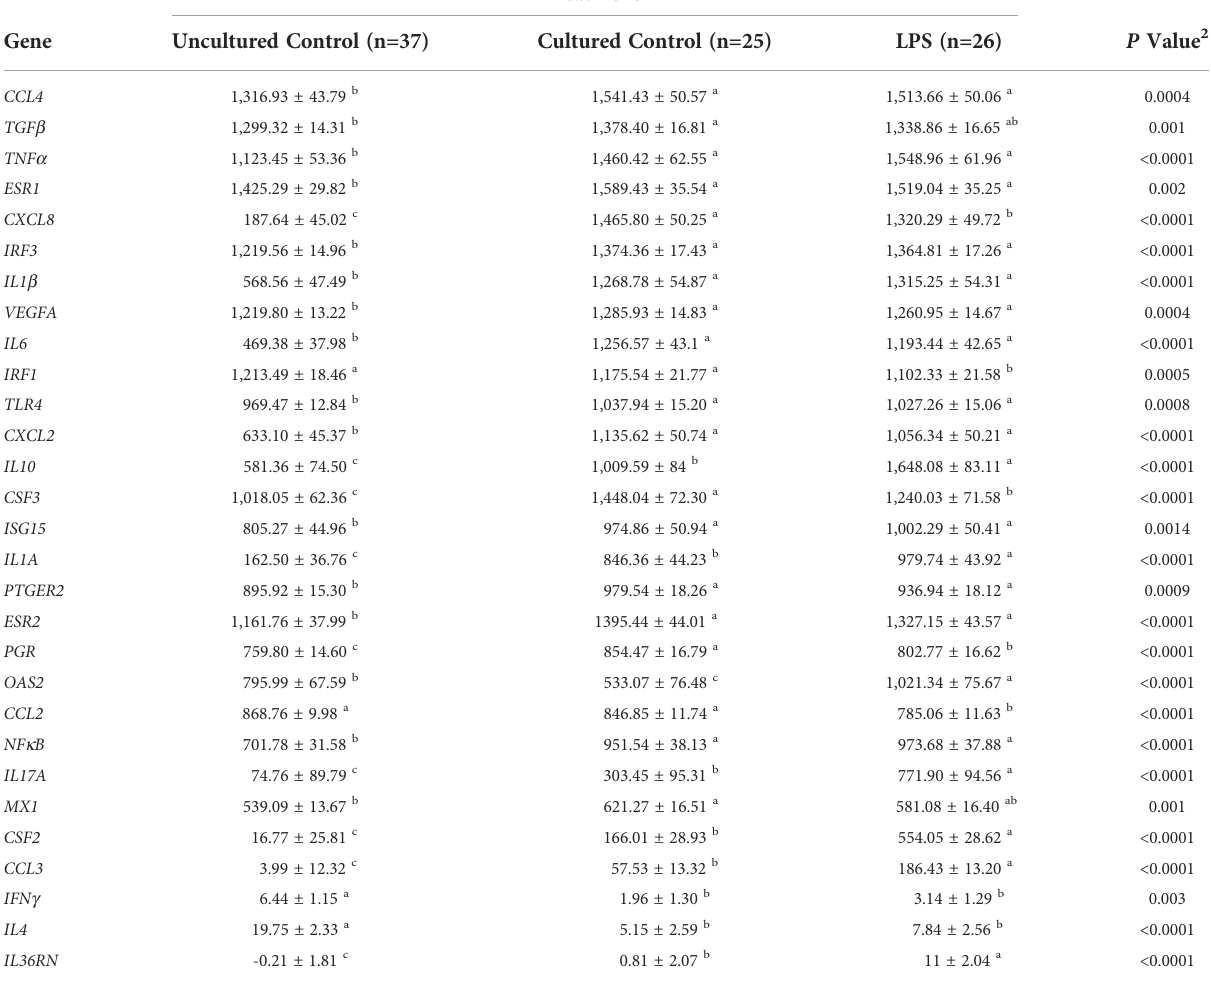
TABLE 3 Expression of genes affected by treatment